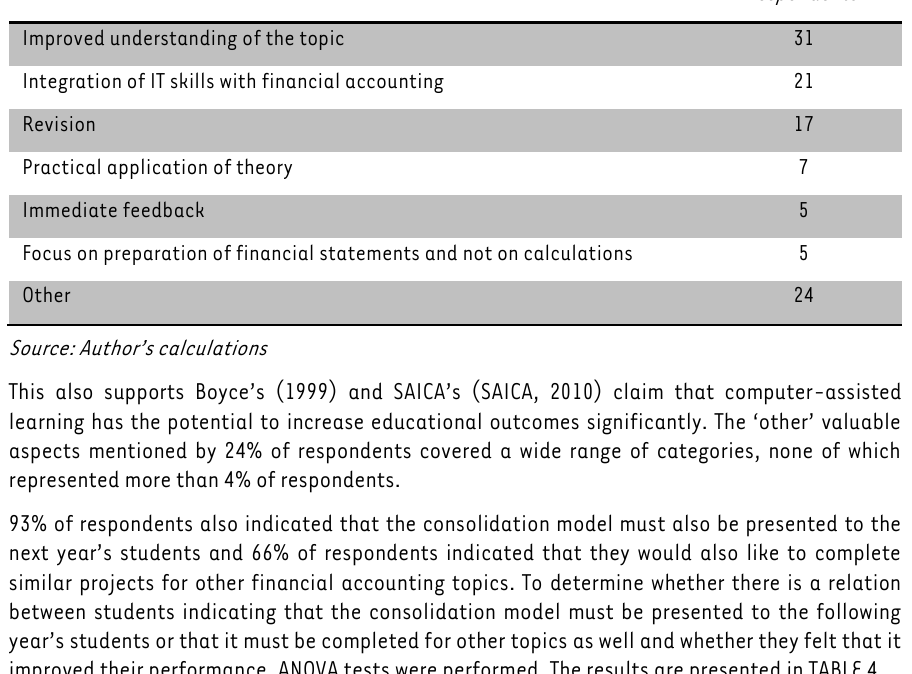
TABLE 4: Relation between the continuing integration of IT skills with financial accounting and students’